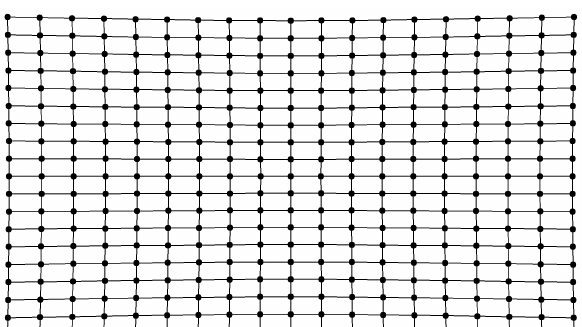
Figure 16. Barrel distortion.